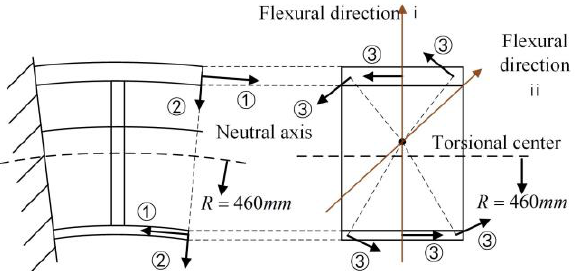
Figure 7. Illustrations of three external loads applied on the FE model of the stator: ① bending moment ( ) 1N m M  ② shear force () 1 N Q ③ torsional moment ( ) 1N m T  . moment M ( 1N · m ) 2 (cid:13) shear force Q ( 1N ) 3 (cid:13) torsional moment T ( 1N · m )